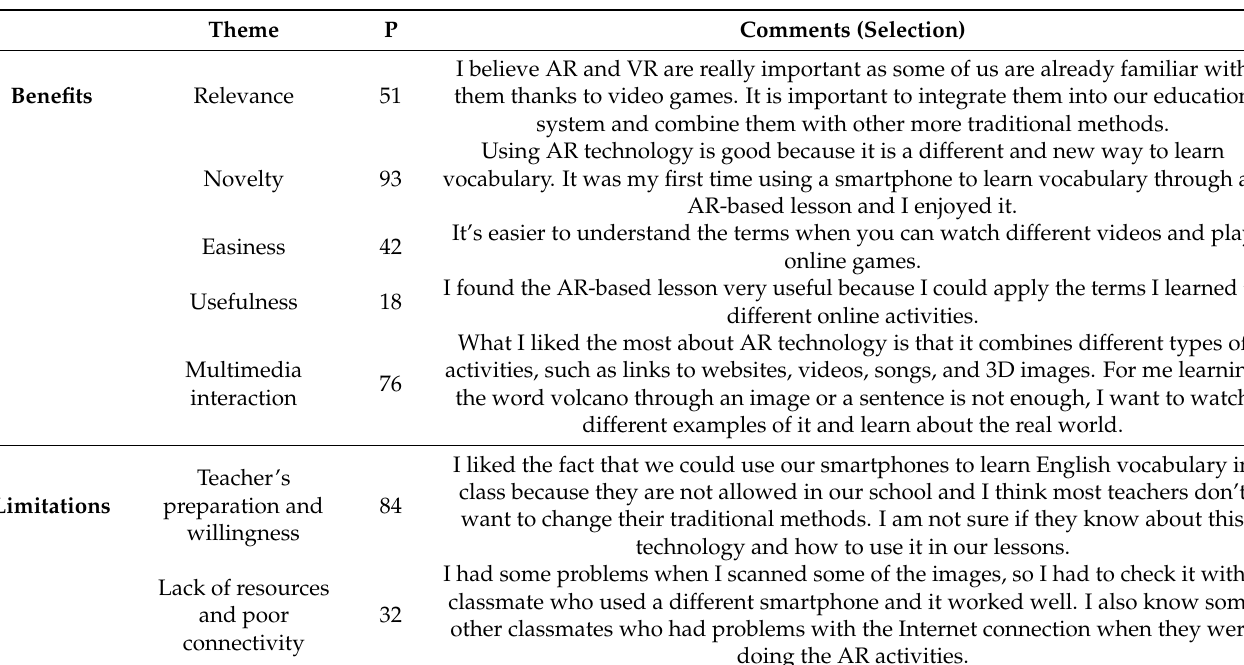
Table 8. Thematic analysis: comments about AR